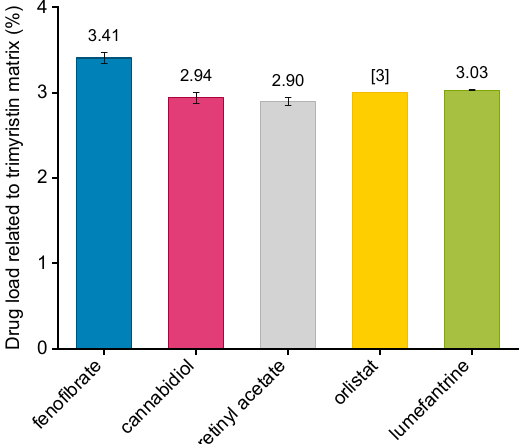
Figure 3. Drug loads of emulsions in relation to trimyristin as determined via UV/VIS spectroscopy. The drug load of orlistat was not quantified and the respective value [digit] is the weighed-in amount. Each value represents mean ± standard deviation ( n = 3).